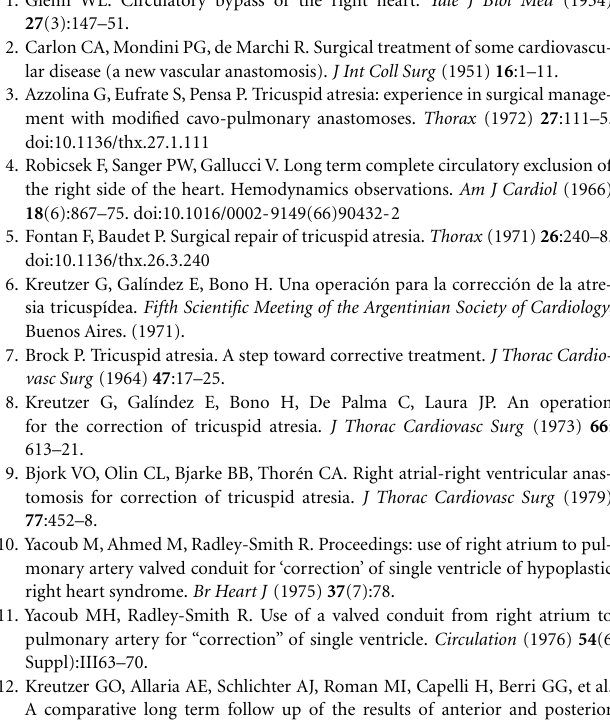
thrombus. Fortunately her left ventricular function was